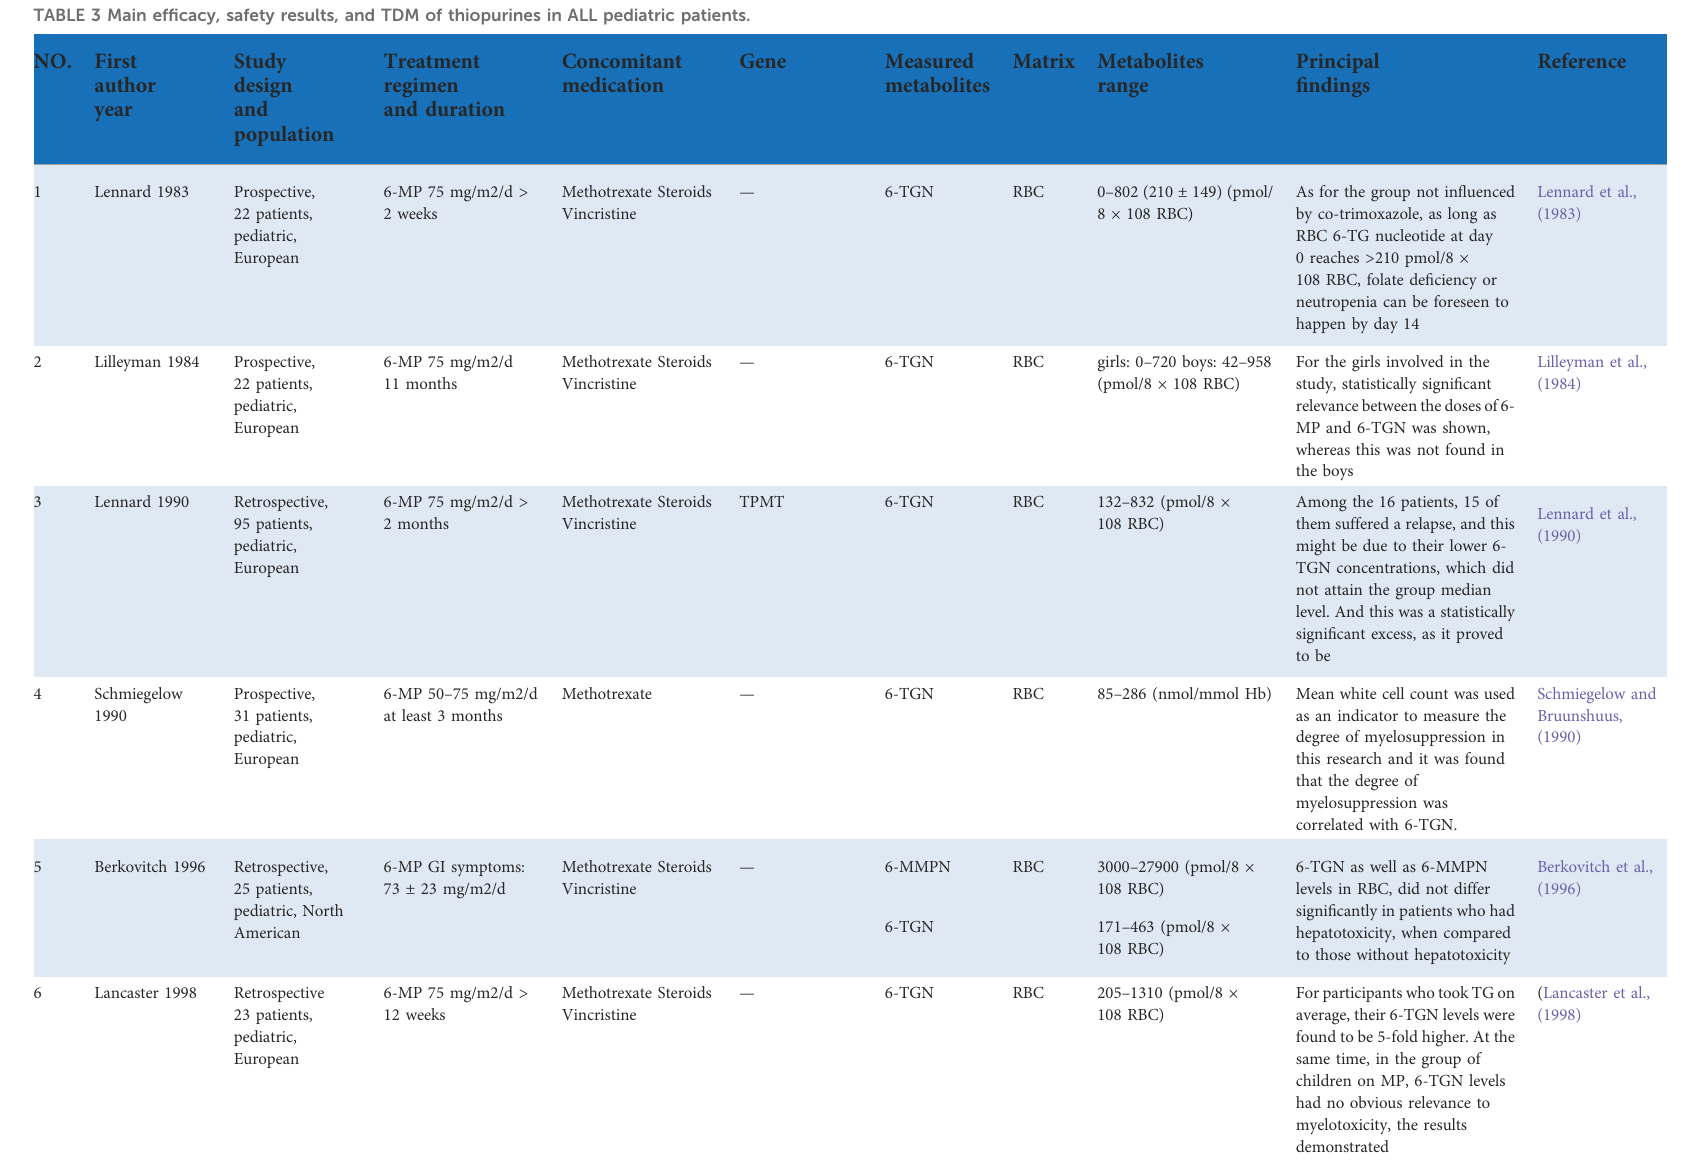
TABLE 3 Main ef fi cacy, safety results, and TDM of thiopurines in ALL pediatric